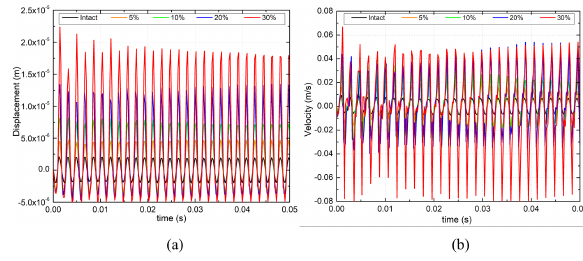
Figure 10: Dynamic response of frequency ratio η =1/2 between intact and debonded models a) displacement b) velocity.